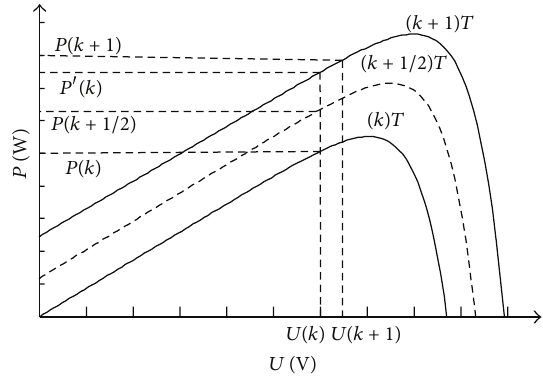
Figure 8: Power prediction schematic.